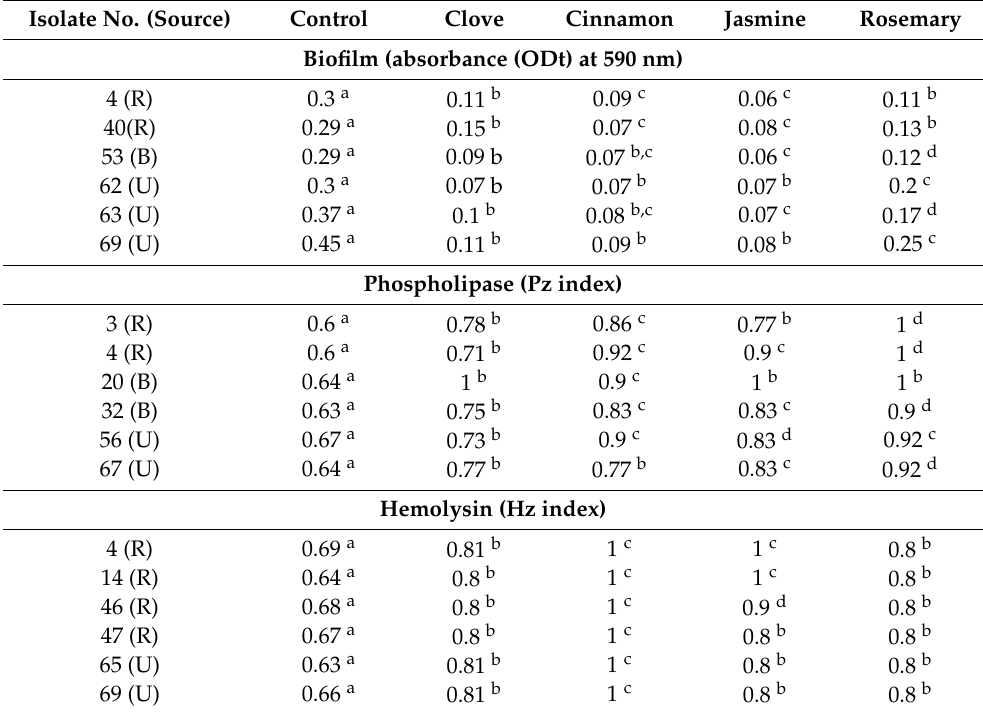
Table 3. Inhibition of C. albicans phospholipase, hemolysin and biofilm formation using sub-inhibitory concentration ( 1 MIC) of different 4